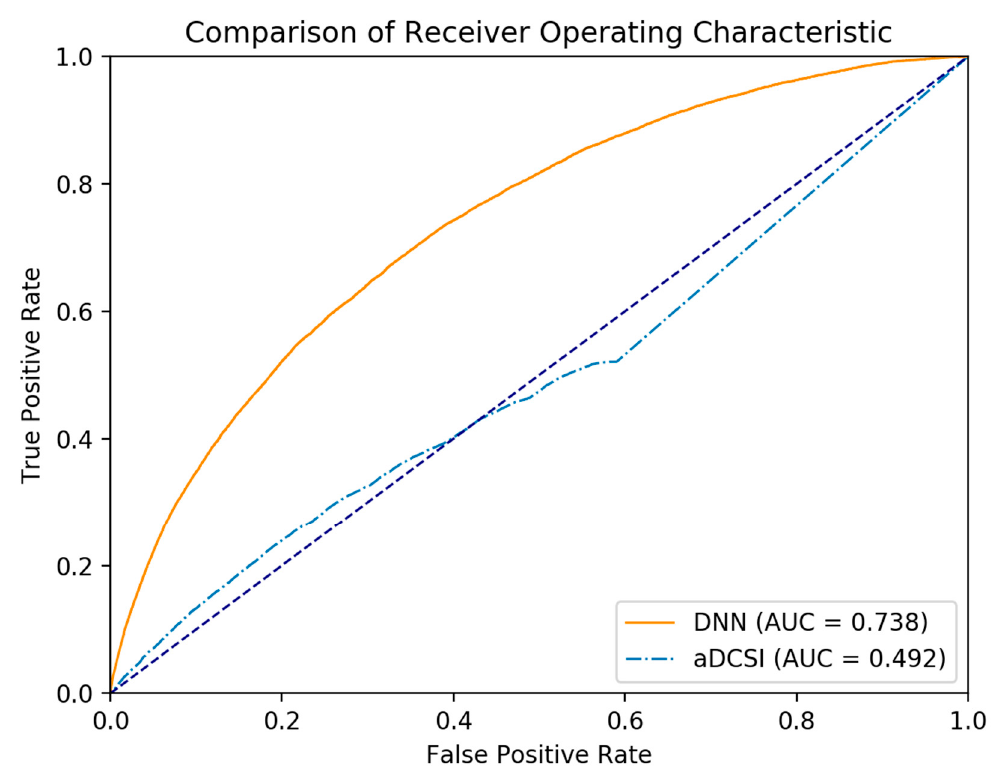
Figure 1. The ROC curve of the DNN model and aDCSI model in predicting CRC.